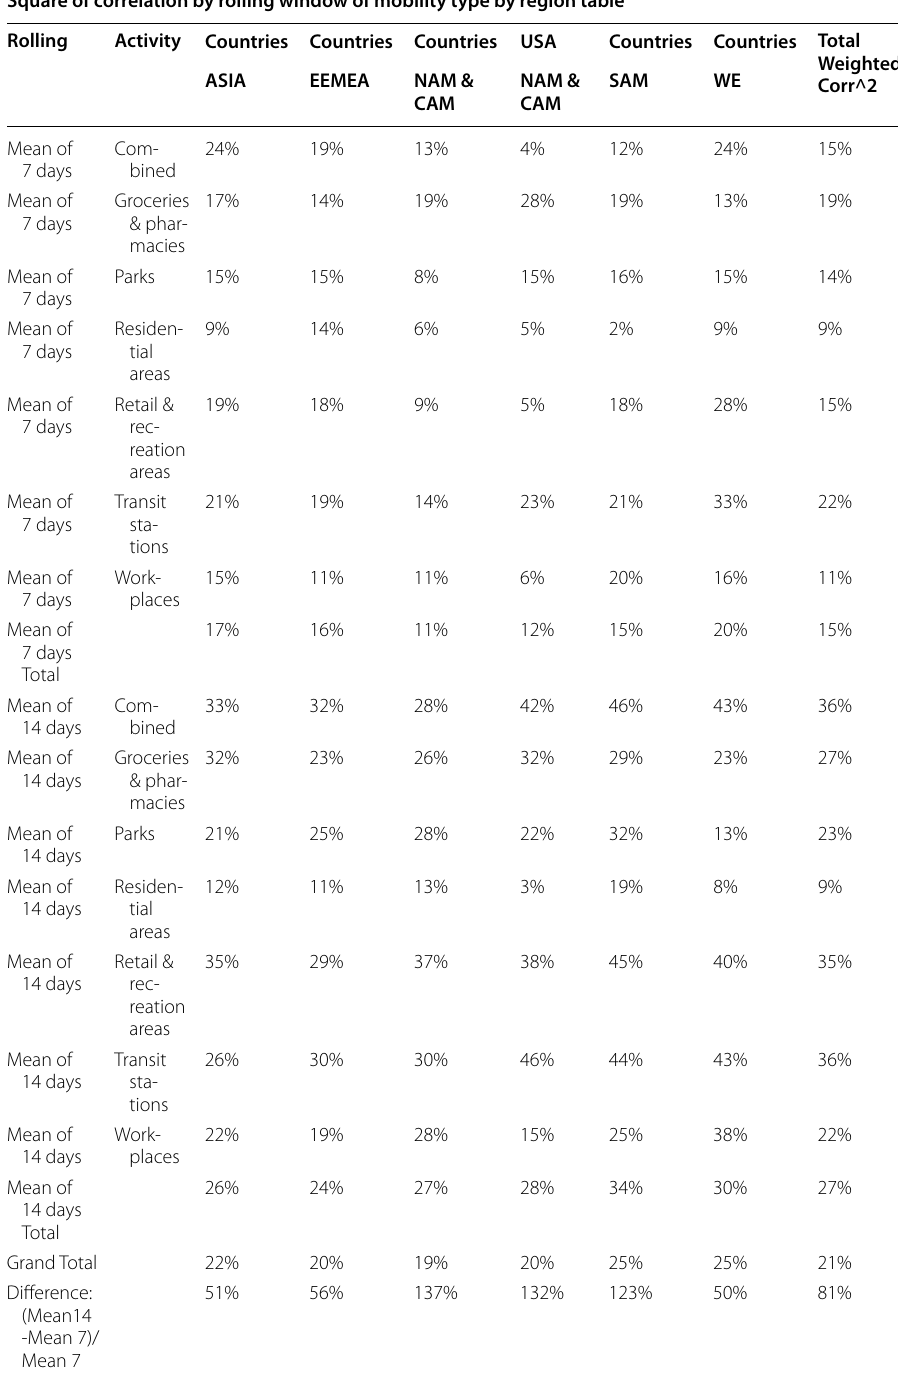
Table 3 Square of correlation by rolling window of mobility type by region Square of correlation by rolling window of mobility type by region table